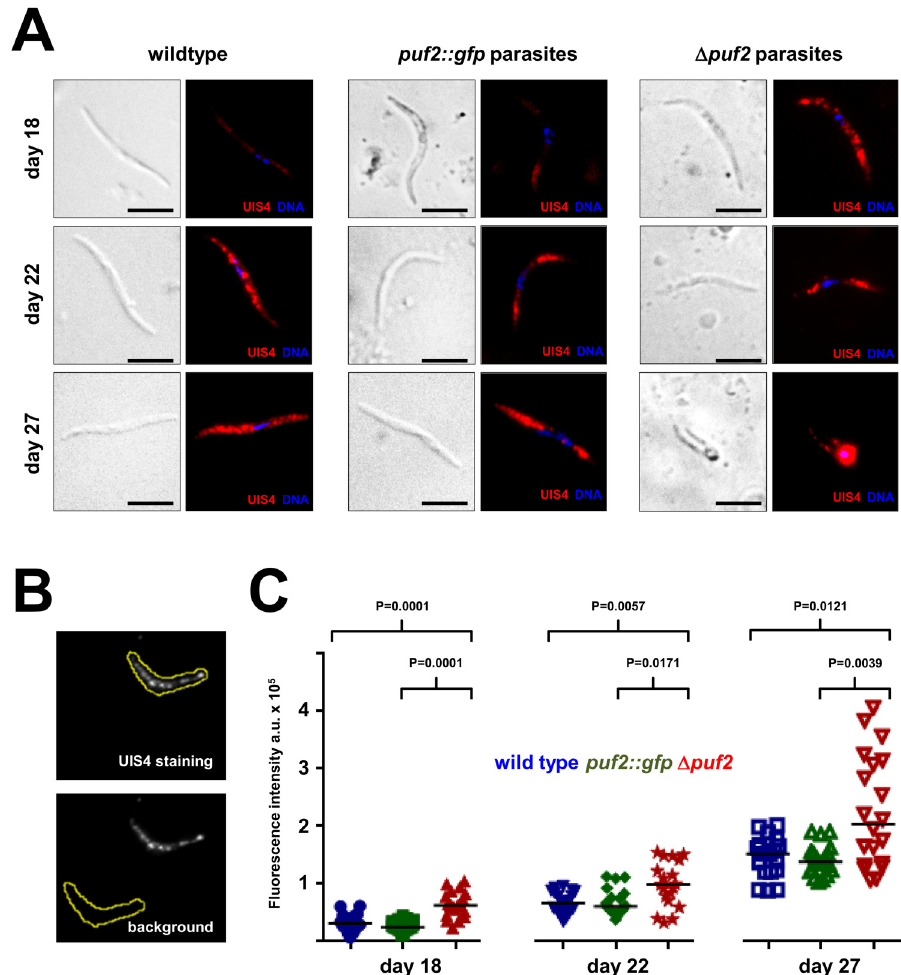
Fig 3. UIS4 protein expression is upregulated in puf2 salivary gland sporozoites. (A) UIS4 was detected by immunofluorescence assay with a goat anti-UIS4 antibody (SICGEN) in salivary gland sporozoites from days 18, 22 and 27 post-mosquito infection in the indicated parasite lines. Note the change in morphology of the puf2 sporozoite. Scale bars = 5 μ m. (B) Fluorescence images representing the quantification method used with ImageJ software. UIS4 immunofluorescence of a puf2 sporozoite at day 22 post-mosquito infection is shown. The shape of the sporozoite was outlined; the same shape was placed on a neutral area of the image to obtain a background value. Fluorescence intensities of the sporozoite and background were determined with ImageJ software as explained in the Material and Methods. (C) Scatter plot representation of the UIS4 fluorescence intensity measurements (arbitrary units a.u.) are shown (n = 20 for each timepoint and parasite line). P-values were obtained by Mann-Whitney